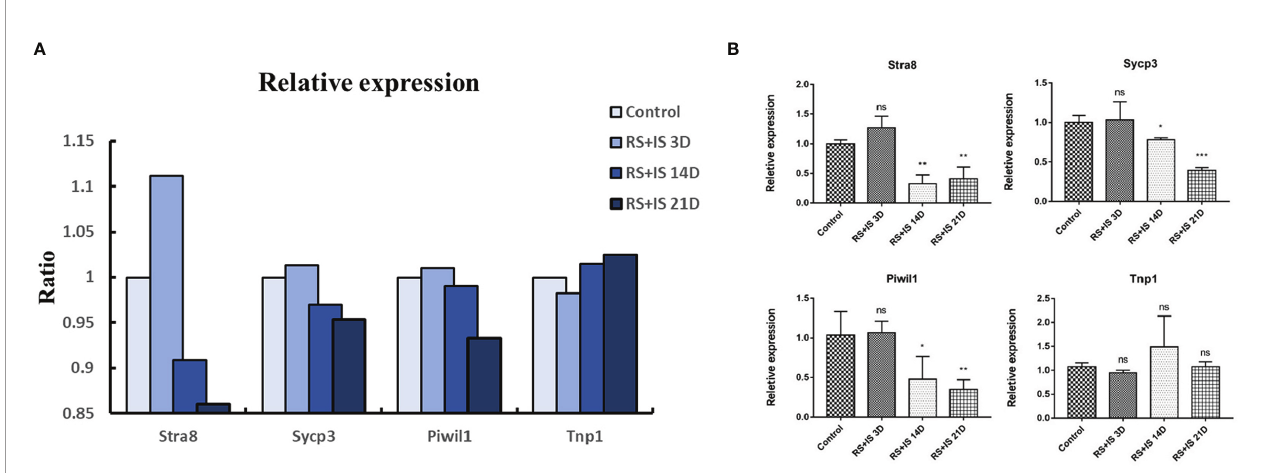
FIGURE 4 | (A) Relative expression (TPM) of germ cell marker from RNA-seq. (B) Result of RT-qPCR. Data are expressed as the mean ± SD, n = 6. Values with different superscripts indicate signi fi cant differences between control and RS+IS groups on one-way ANOVA (* P < 0.05, ** P < 0.01, *** P < 0.001). The mRNA expression levels of Stra8, Sycp3, and Piwil1 were signi fi cantly downregulated in chronic stressed groups. ns, non-signi fi